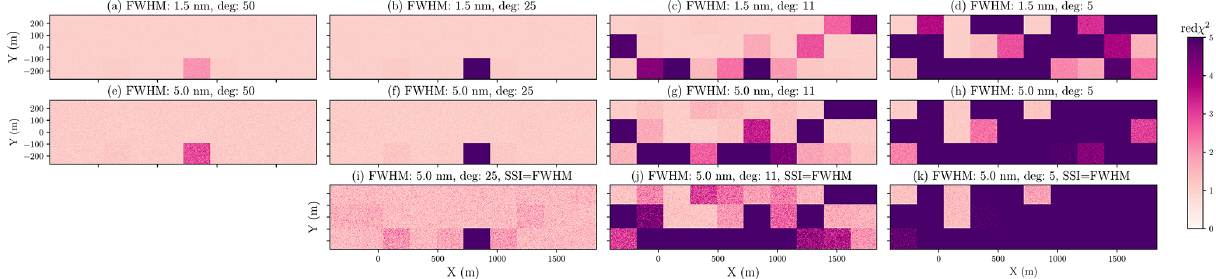
Figure 13. A plot showing the values of reduced χ 2 from the retrieval for different instrument FWHM and polynomial degrees. As the polynomial degree becomes higher, the reduced χ 2 decreases, implying a better spectral fit.